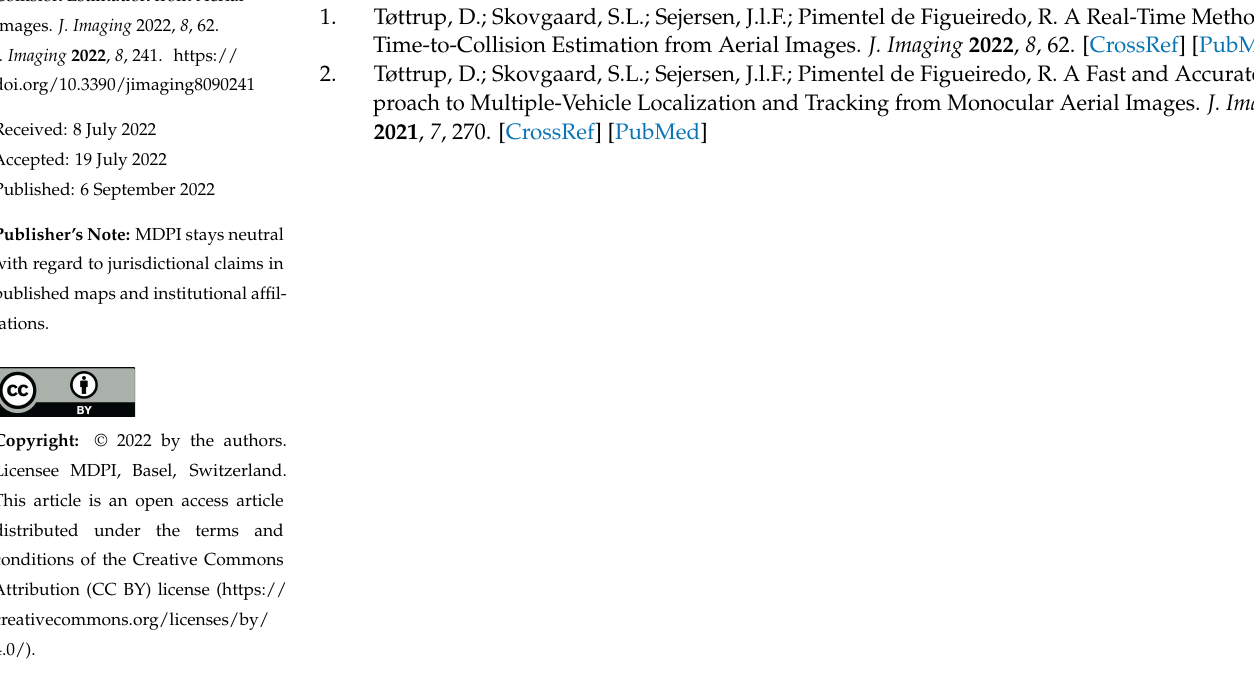
Figueiredo, R. Correction: Tøttrup et al. A Real-Time Method for Time-to- Collision Estimation from Aerial Images. J. Imaging 2022, 8 ,